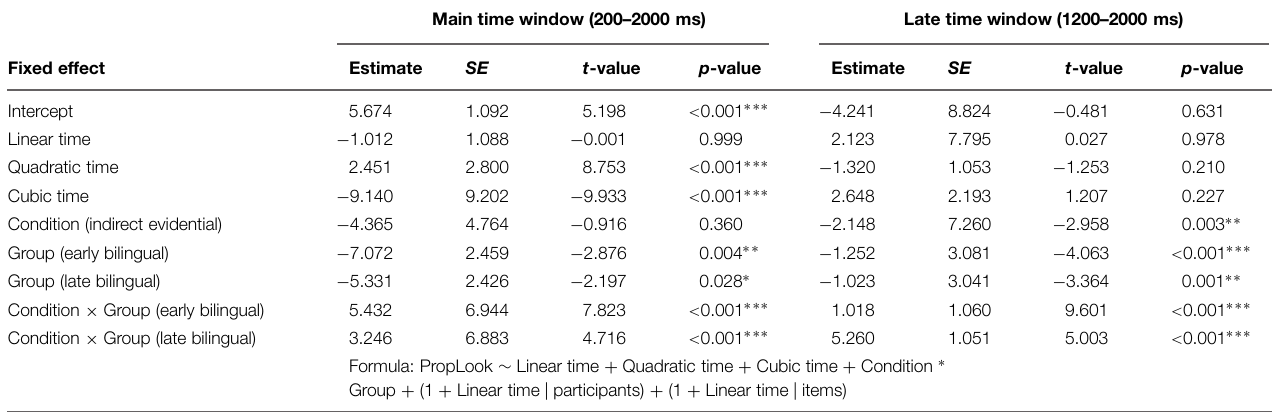
TABLE 4 | Fixed effects from the mixed-effect logistic regression model performed on the proportion of looks data in the main time window (200–2000 ms) and late time window (1200–2000